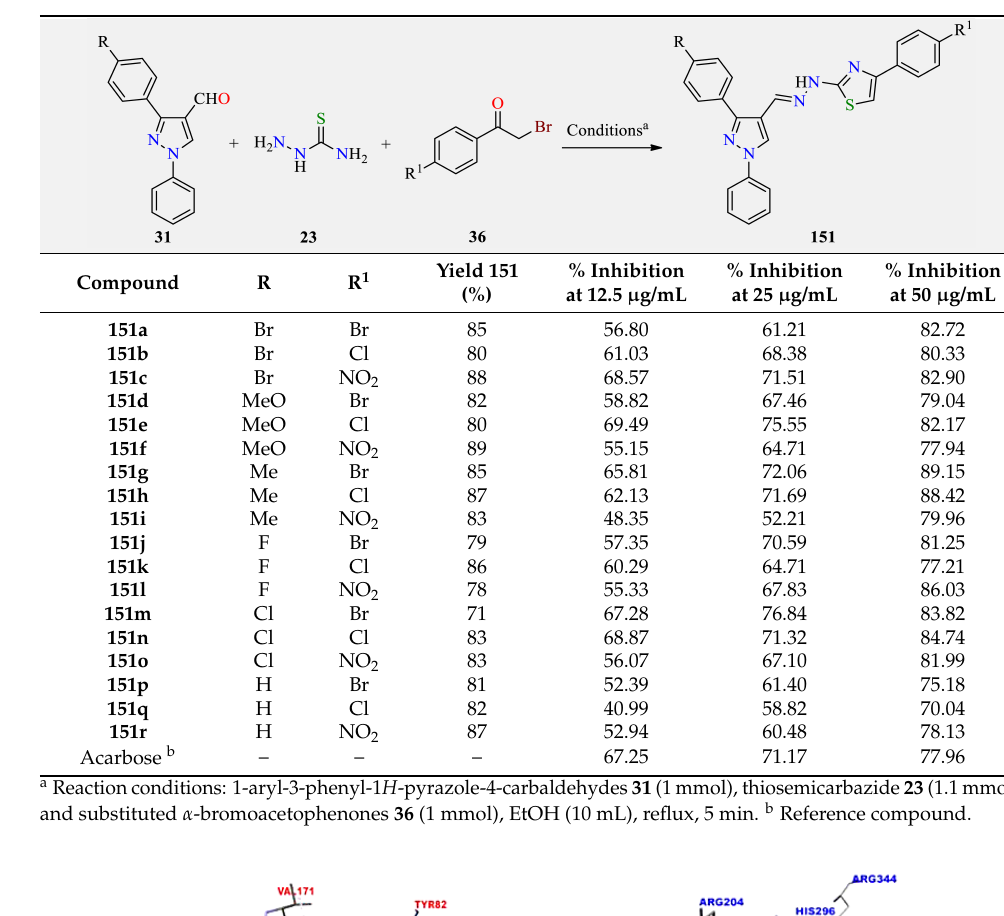
Table 46. Three-component synthesis and α -amylase activity of thiazole–pyrazole hybrids 151 .